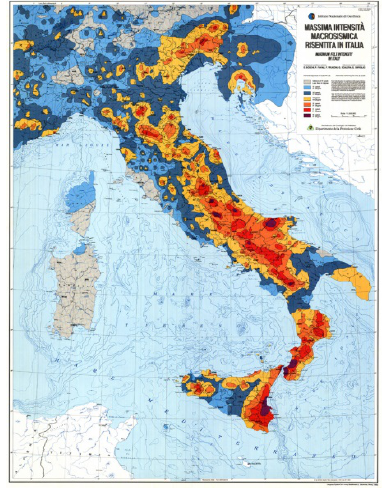
Figure 3. Map of Maximum Macroseismic Intensity observed, the database Macroseismic DBMI11 Italian